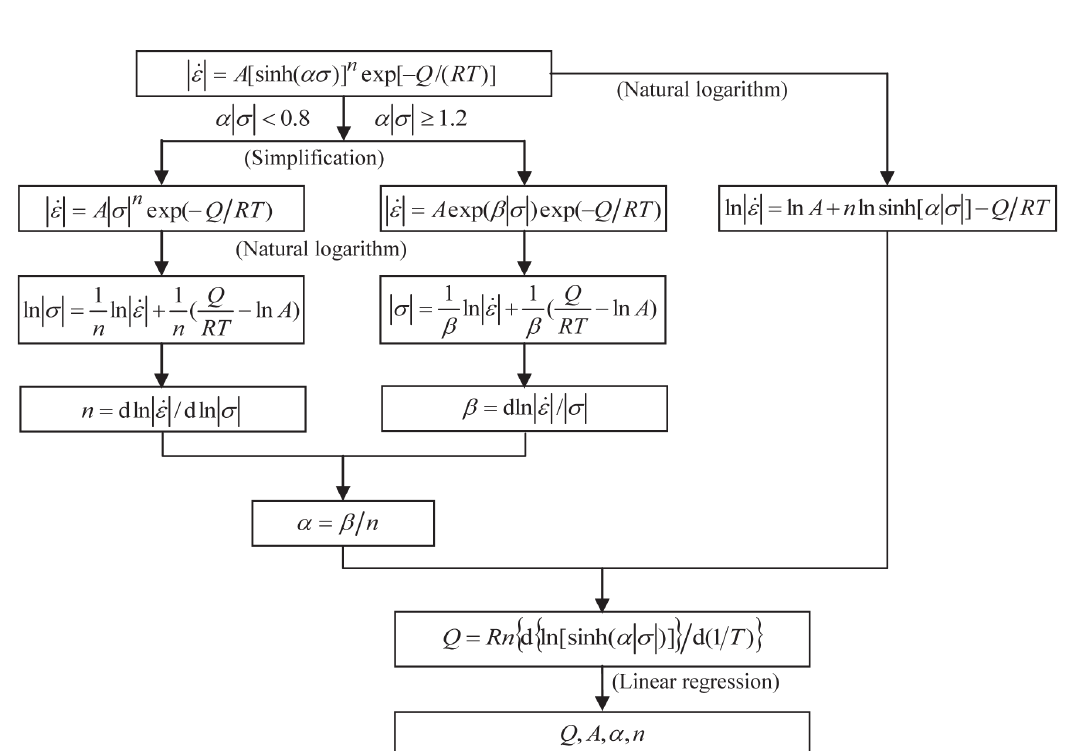
Figure 4. Flow diagram for determining all parameters in constitutive